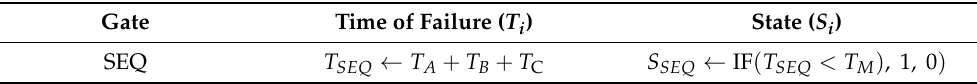
Table 4. Logical expression for deriving the output of an SEQ gate.